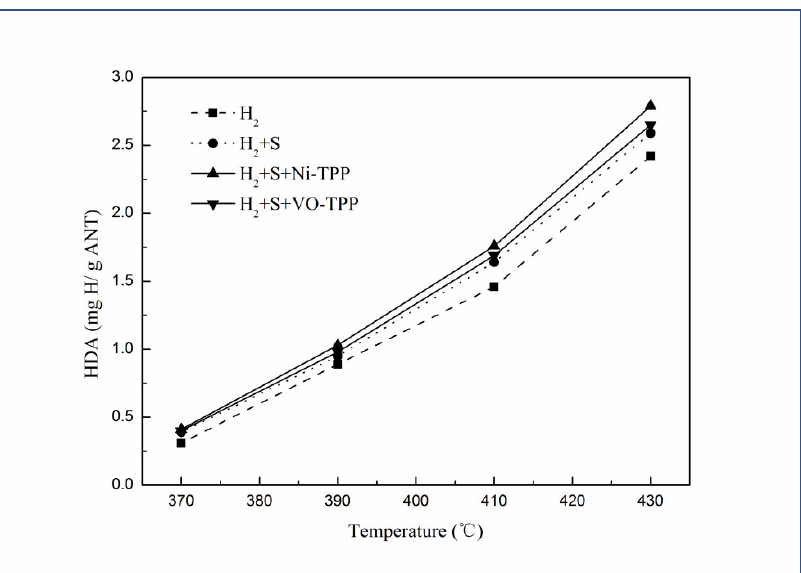
Figure 5. HDA of hydrogen with S and metalloporphyrin.